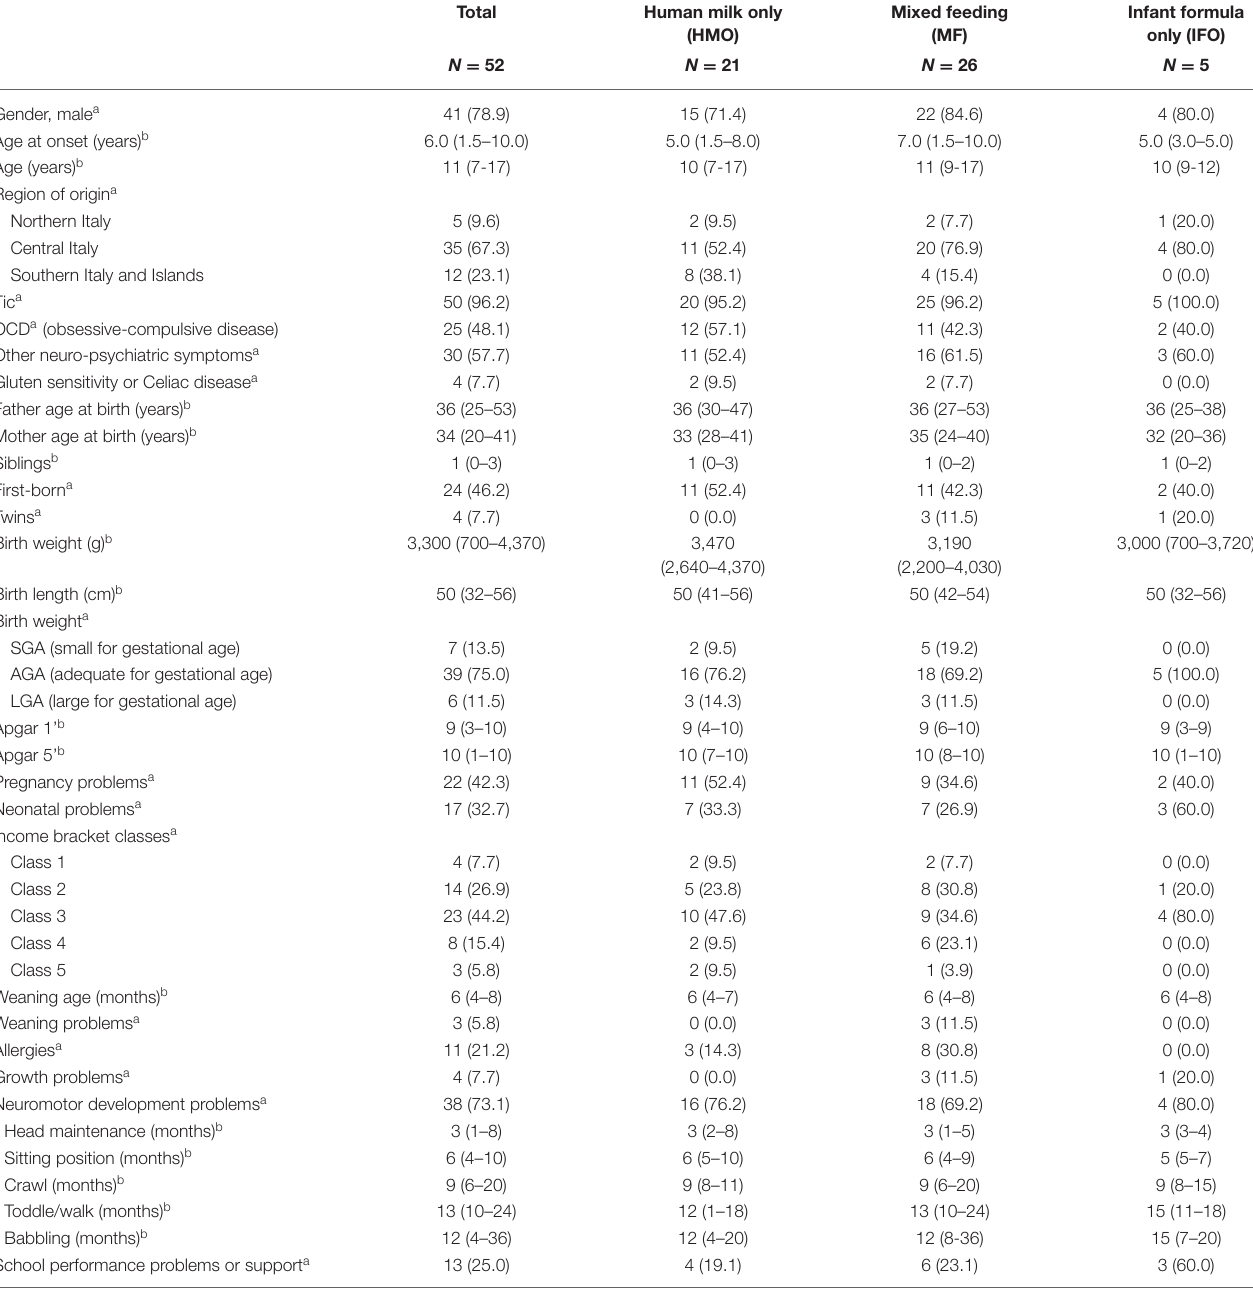
TABLE 2 | Characteristics of the study population and of the subgroups.